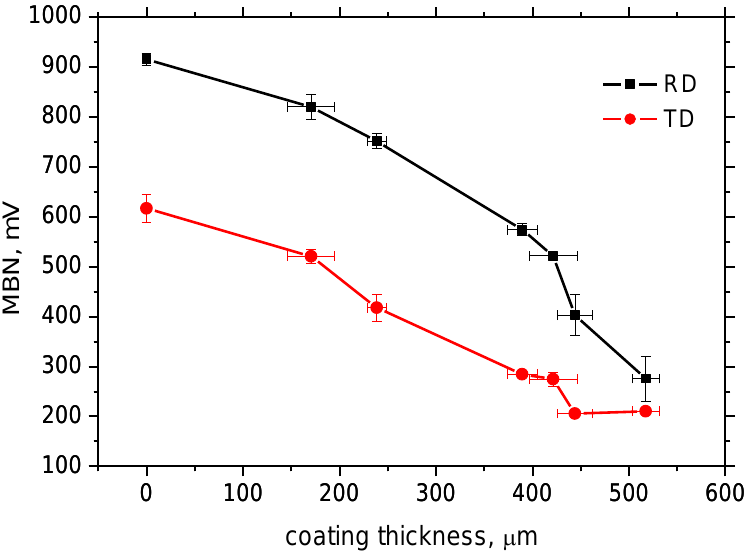
Figure 5. Coating thickness (obtained from the LM observation) versus MBN. Figure 6 illustrates that the increasing coating thickness also altered the MBN en- velopes. The maximum of these envelopes was shifted towards the higher magnetic fields, and the maximum was reduced. The progressive shift of the envelope’s maximum cor- responds with PP as illustrated in Figure 7. The main reason is due to the coating on the steel surface, which makes the real magnetic fields in the ferromagnetic matrix weaker. Hence, the DWs unpinning occurred later at stronger magnetic fields during the cyclic magnetization within the hysteresis loop. The decreasing maximum of the MBN envelopes was mainly due to weaker real magnetic fields in the sample (some DWs remain unpinned) and the superimposing contribution of the attenuation of electromagnetic pulses during their propagation towards the free